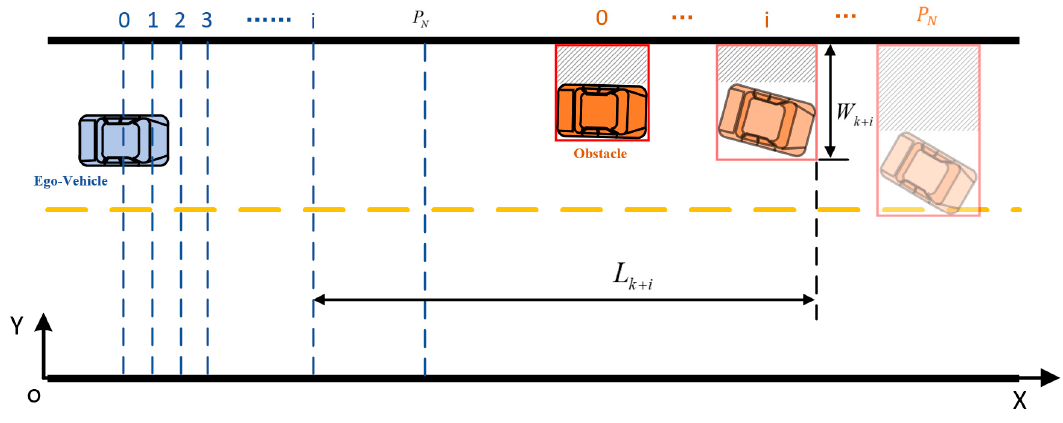
Figure 6. Collection of GPR model input parameters in MPC prediction horizon.